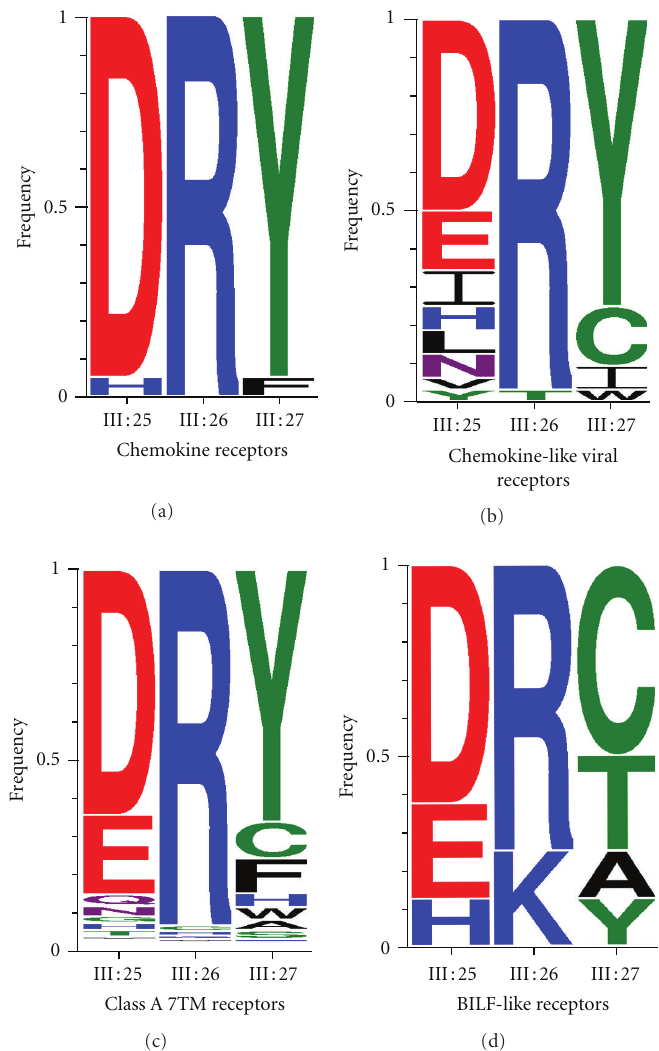
Figure 2: Sequence logos of the DRY-motif for chemokine receptors (a), chemokine-like viral receptors (b), class A 7TM receptors (c), and BILF-like receptors (d). The chemical properties of the amino acids are represented in color (polar: green, neutral: purple, basic: blue, acidic: red, and hydrophobic: black). This figure was created using the web application: